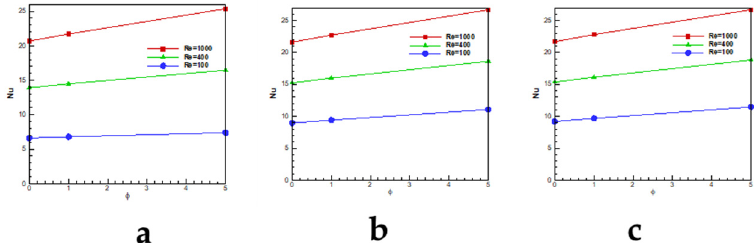
Figure 8. Variation of averaged Nusselt number, at different nanoparticles volume concentration at HR = 0.5. ( a ) Ra = 10 4 , ( b ) Ra = 10 5 , ( c ) Ra = 10 6 .